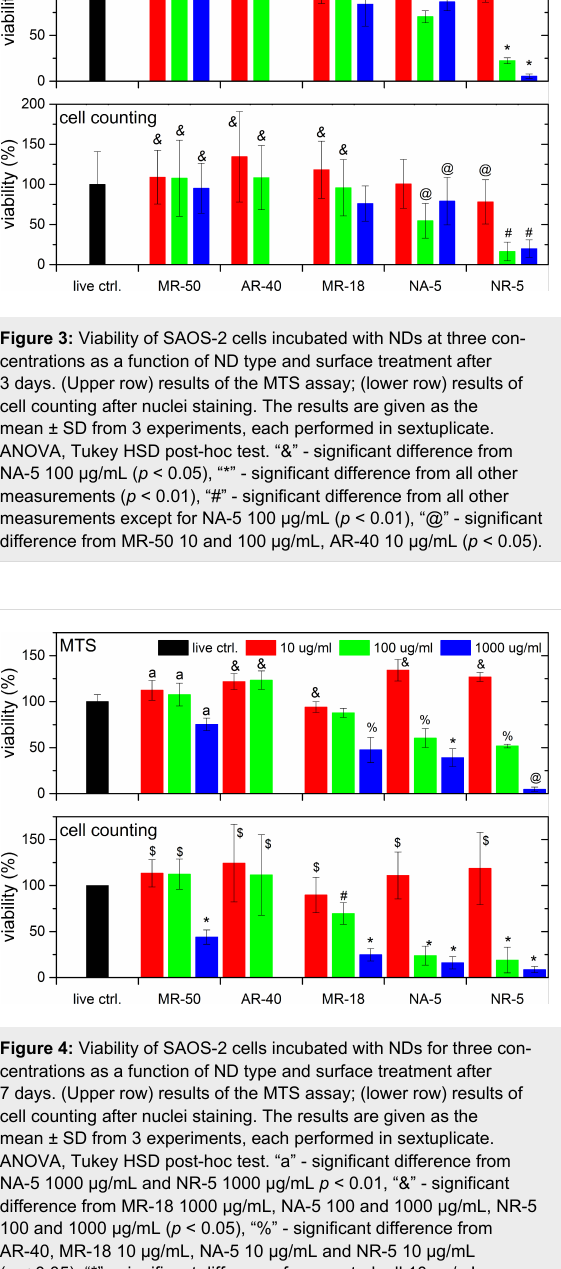
nuclei (lower row) for three different concentrations of 10, 100 and 1000 µg/mL (3, 30 and 300 µg/cm 2 ) as a function of ND type and surface treatment after 3 days (Figure 3) and 7